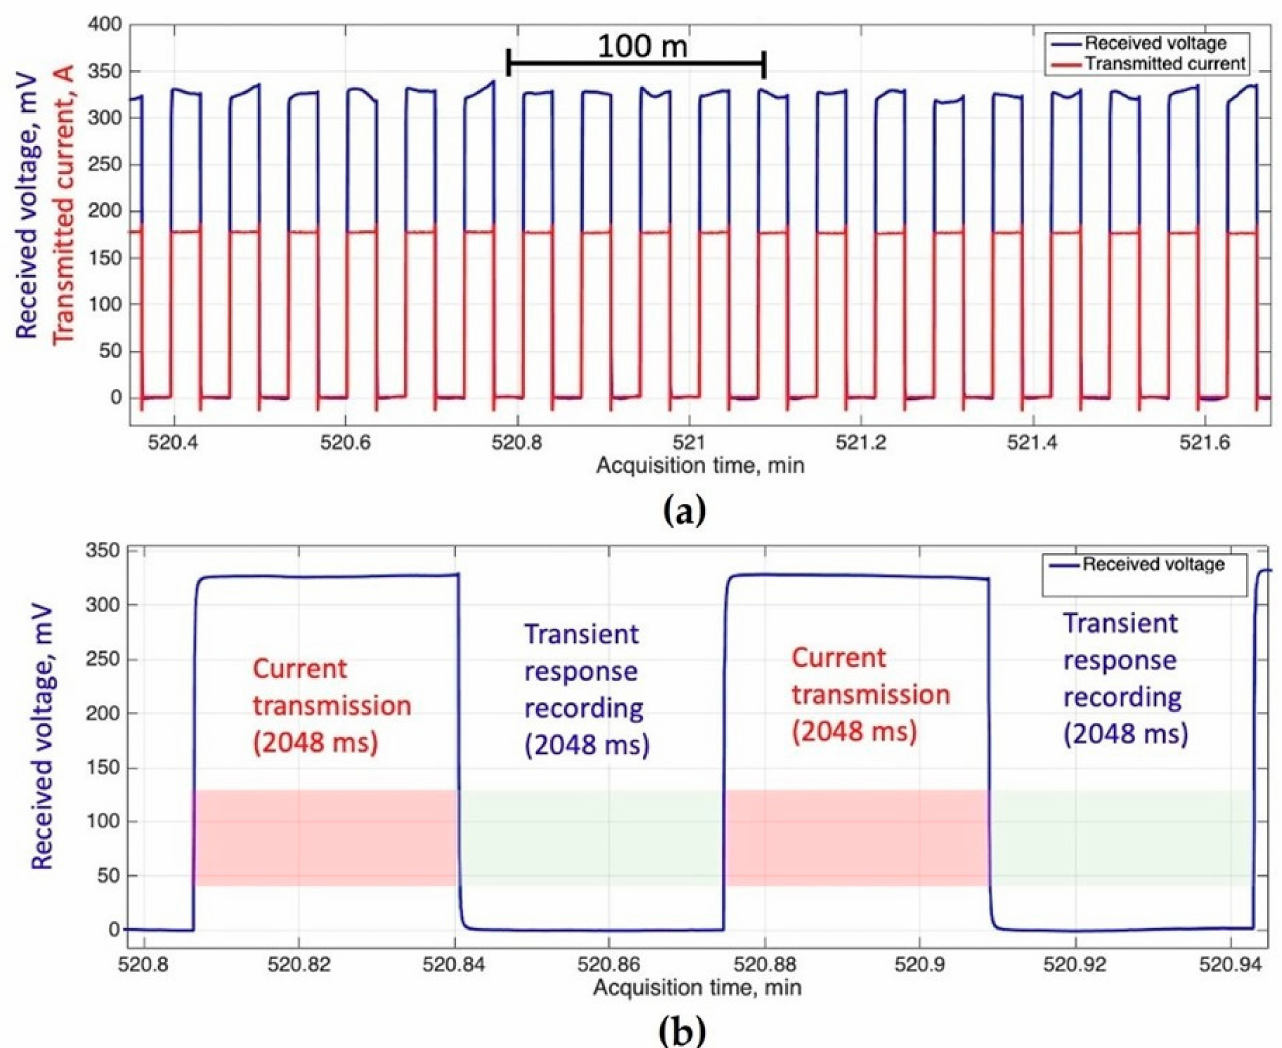
Figure 14. Example of TDEM time series recorded in the southern part of the Laptev Sea. The received voltage is shown in blue, while the transmitted current is in red. Panel ( a ) shows a 1.3 s interval with individual current pulses becoming visible; panel ( b ) provides a close-up of two sequential